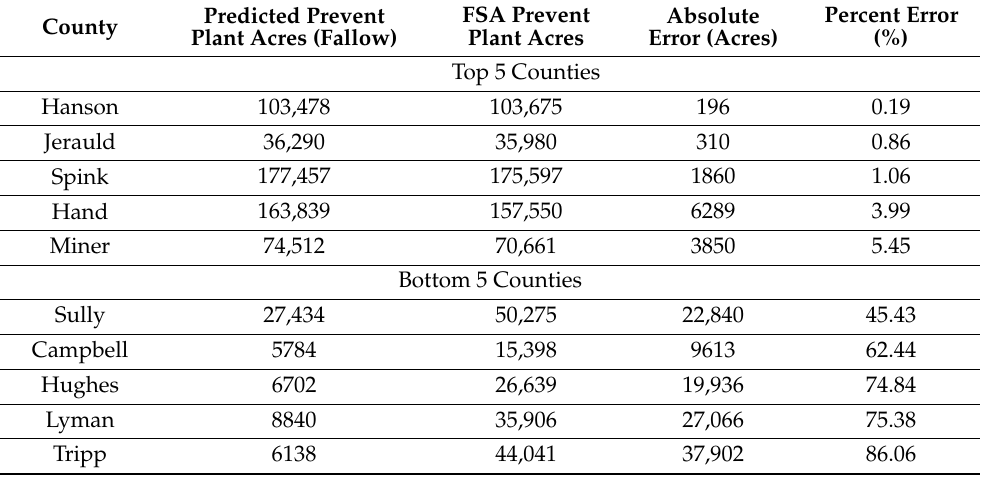
Figure 12. Predicted prevent plant map showing counties most severely affected by flooding in eastern South Dakota in 2019. Table 3. A comparison of FSA-reported and our predicted prevent plant acres, sorted by percent error. Only the top and bottom 5 counties are shown. See Table A1 in Appendix A for all counties.